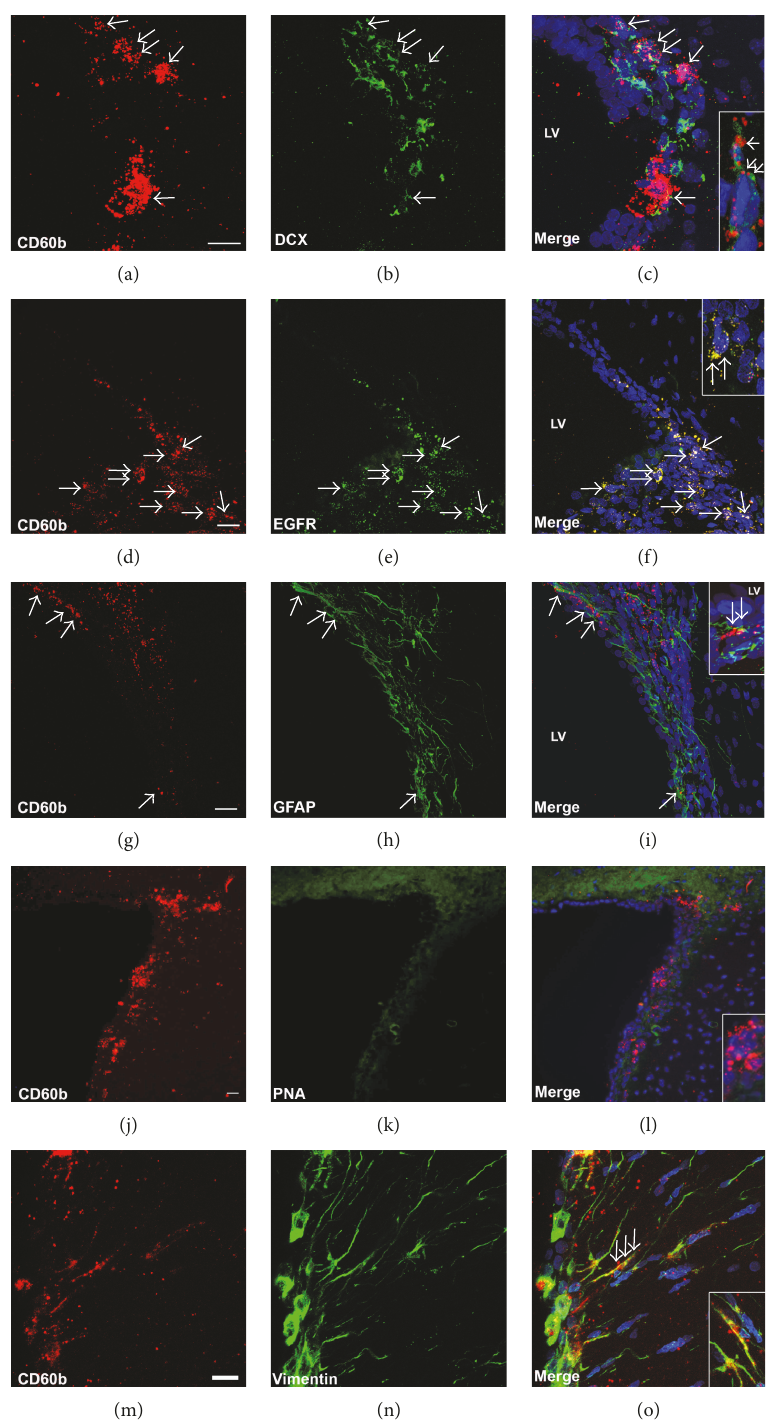
Figure 5: CD60b is expressed in di ff erent populations in the adult SVZ. Confocal images of adult SVZ sections showing the expression of CD60b (a, d, g, j, and m in red) and doublecortin (b-c), EGFR (e-f), GFAP (h-i), PNA (k-l), and vimentin (n-o) (in green). Nuclei were counterstained with TO-PRO-3 (blue). We observed the expression of CD60b in DCX (expressed in neuroblasts), R-EGF (expressed mostly in type C cells), GFAP (expressed in type B cells and astrocytes), and vimentin-positive cells (expressed in radial glia-like cells) (arrows). PNA, which was described as a negative marker of neural stem cells, and CD60b showed little colocalization (l). High magni fi cation is showed in the insets. LV: lateral ventricle; DCX: doublecortin. Scale bar: 20 μ